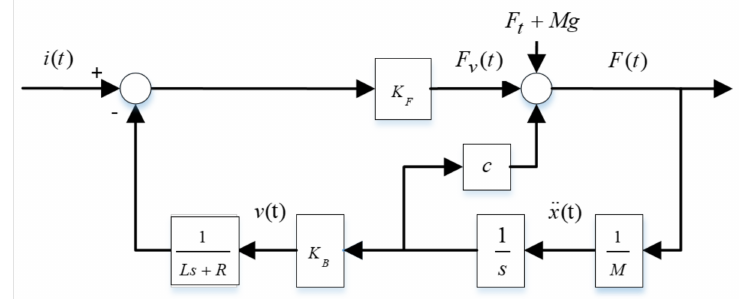
Figure 2. Block diagram of the grinding tool.